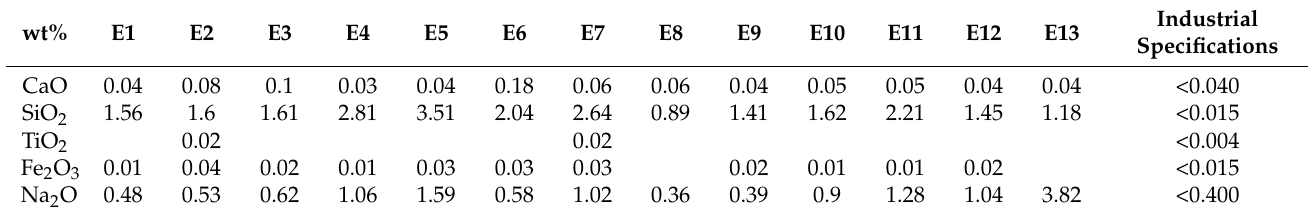
Table 6. XRF results of main contaminants.